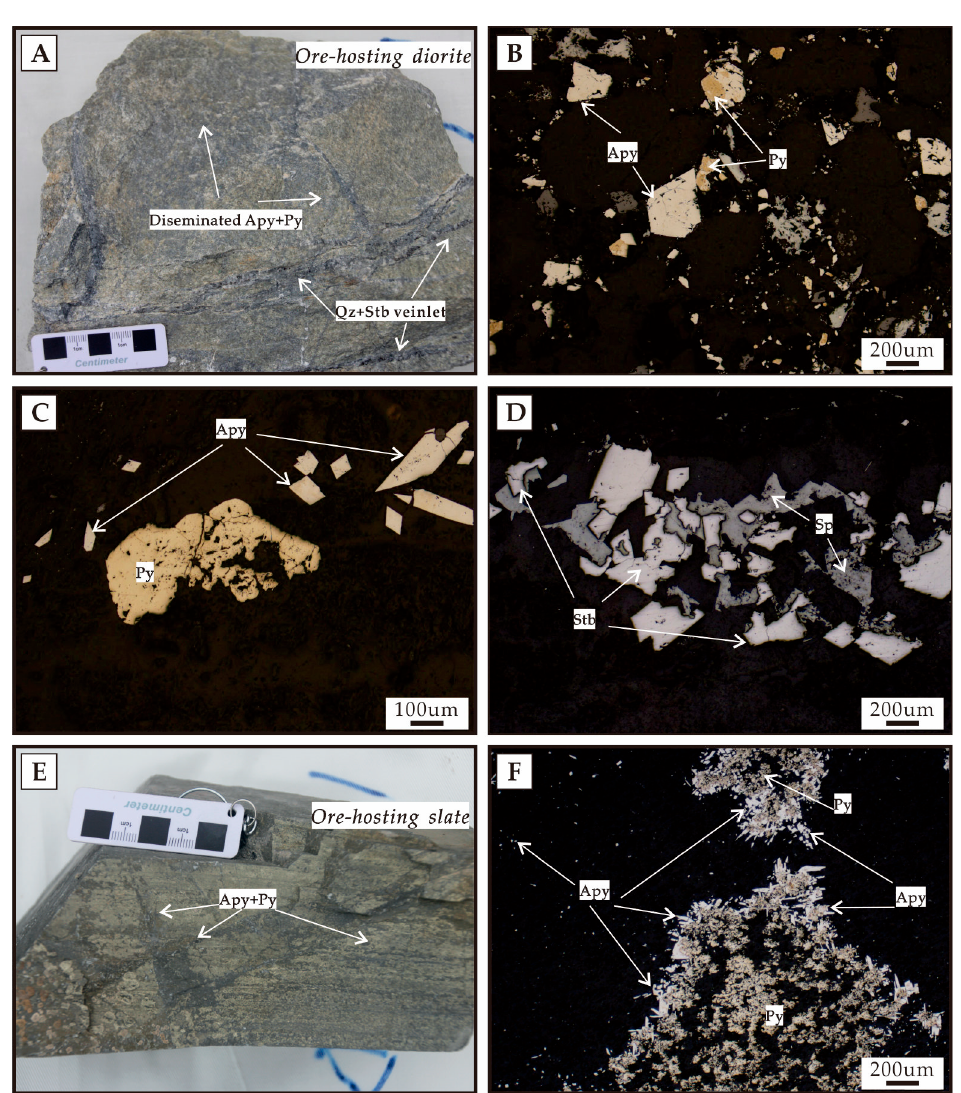
Figure 3. Photographs ( A , E ) and photomicrographs under reflected light ( B – D , F ) showing mineralization styles and mineral assemblages. Disseminations of pyrite and arsenopyrite in diorite ( A – C ). Stibnite veinlet in diorite ( A , D ). Disseminations of pyrite and arsenopyrite in slate ( E , F ). Mineral abbreviations: Apy = arsenopyrite, Py = pyrite, Qz = quartz, Sp = sphalerite, Stb = stibnite.